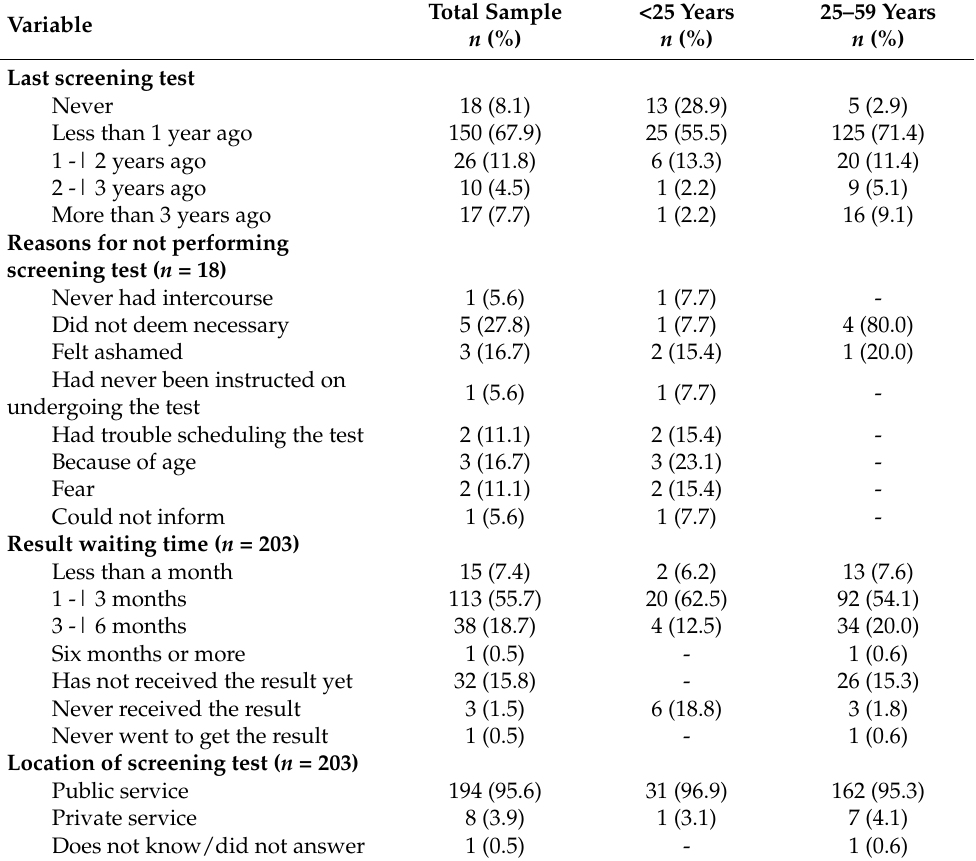
Table 1. Variables related to cervical cancer screening ( n =